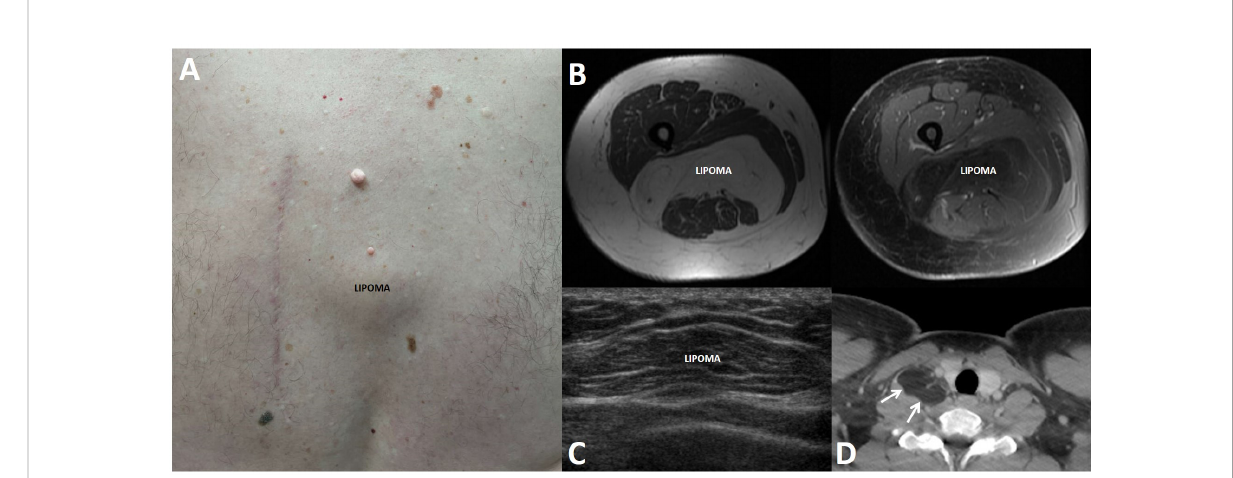
FIGURE 3 Lipomas in patients with multiple endocrine neoplasia type 1. Lipomas are benign tumors made of mature adipocytes that can arise from anywhere that fat is located. (A) 62-year-old man with a subcutaneous lipoma located over the spine in the mid back. Also seen is an adjacent surgical scar related to the prior resection of a large lipoma and scattered collagenomas. (B) 49-year-old woman with multifocal intramuscular lipomas, including a large posterior thigh lipoma as seen on axial T1-weighted pre- (left panel) and post-contrast (right) magnetic resonance imaging. (C) 16-year-old boy with a mobile soft tissue mass arising over the lower anterior chest. Ultrasound showed a 3.7 cm lesion consistent with lipoma. (D) 25-year-old man with a 3.6 cm lipoma (arrows) in the right scalene muscle, adjacent to the right thyroid lobe, as seen on contrast-enhanced computed